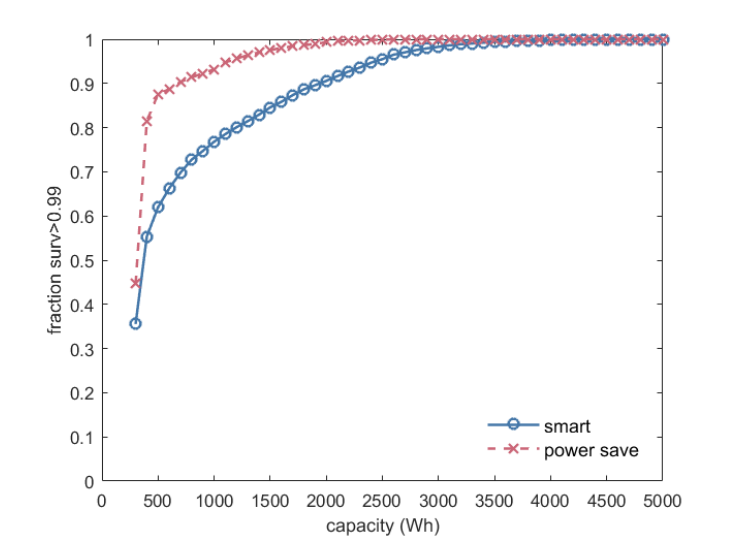
Figure 11. Fraction of time of the year the survivability is larger than 0.99, as a function of the battery capacity for the strategies smart and power-save, with a backup capacity of